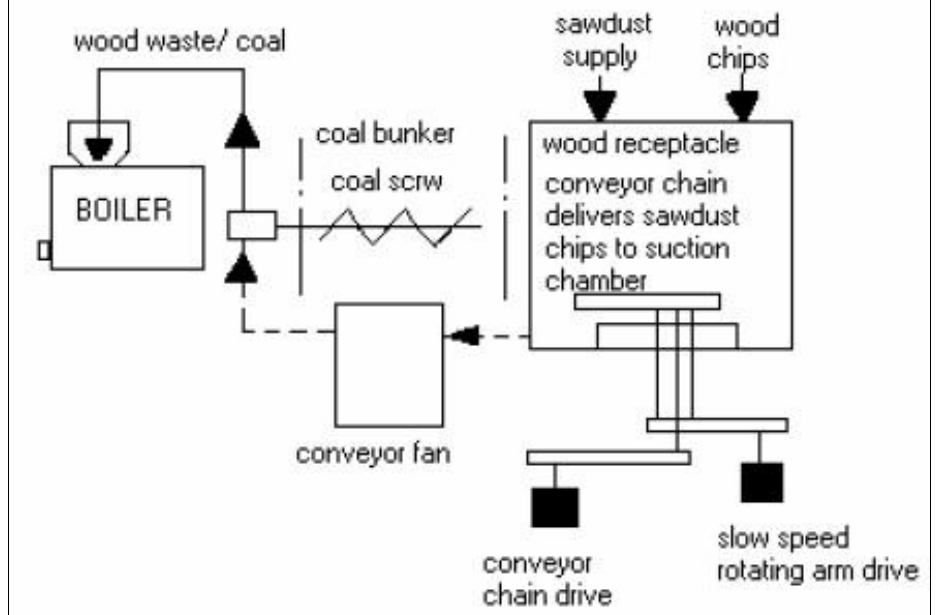
Fig. 11. A schematic diagram of a steam raising plant (D OSUNMU & A JAYI ,